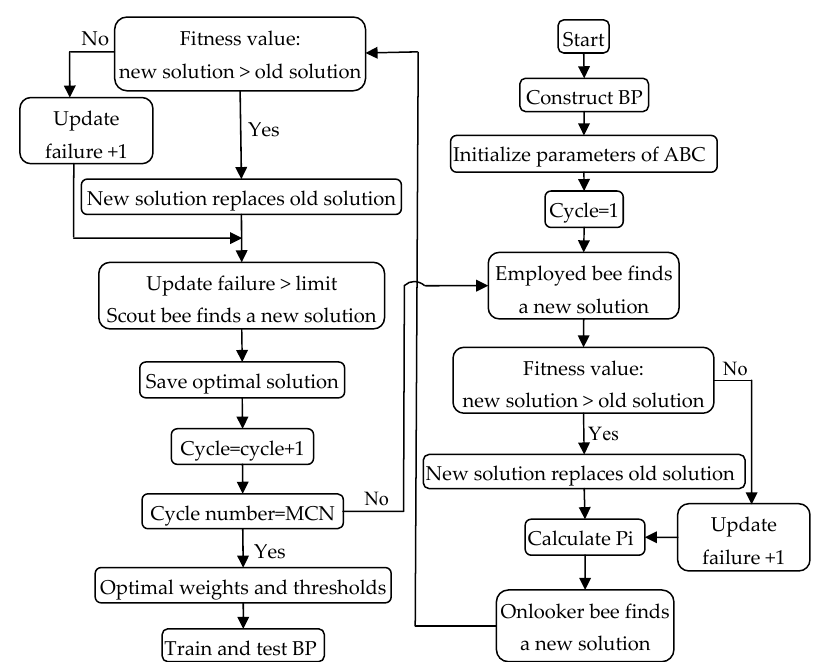
Figure 3. Flowchart of the BP neural network based on the ABC algorithm. (modified from Su et al., 2012 [24]).